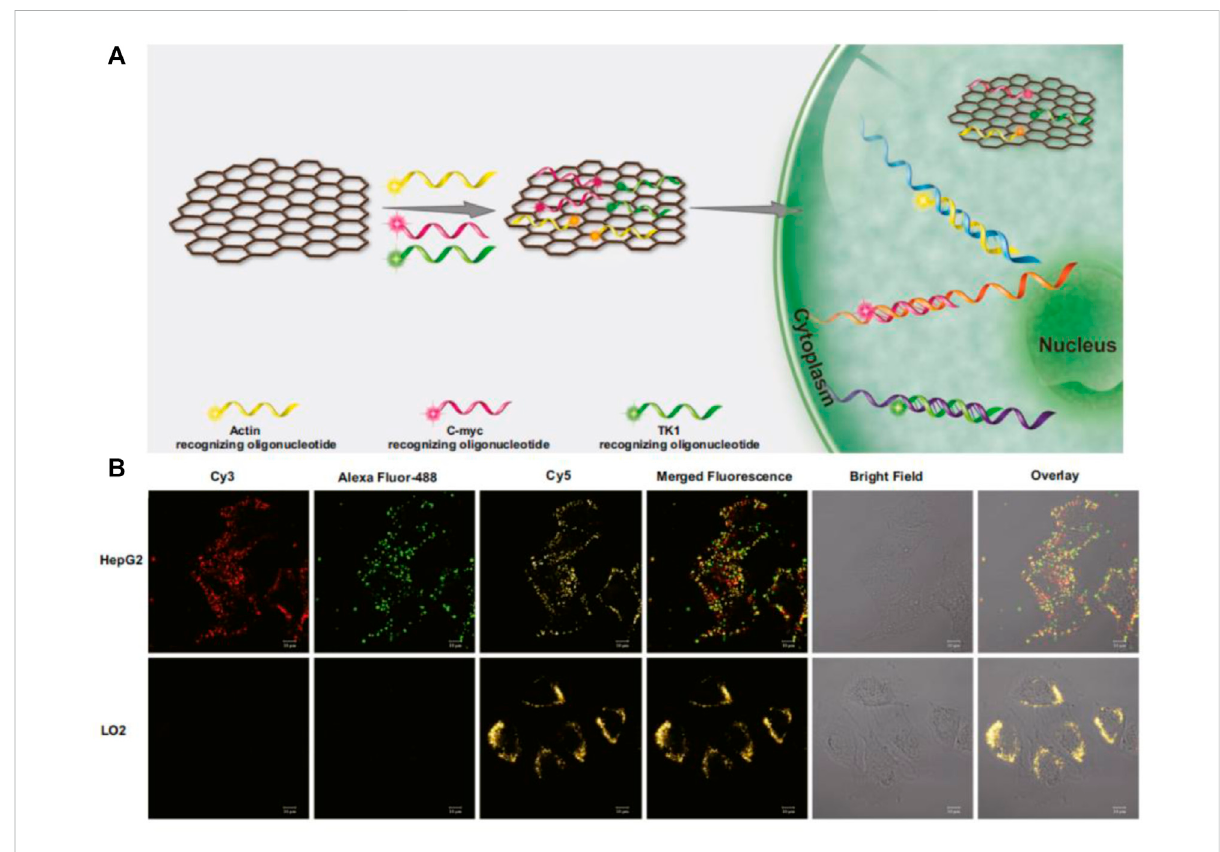
FIGURE 6 (A) Working mechanism of GO-based nanoprobe detection. (B) The GO-based nanoprobe simultaneously imaging detection of three mRNAs in cells. (Jiang H. et al., 2018). Copyright 2018 Springer-Verlag GmbH